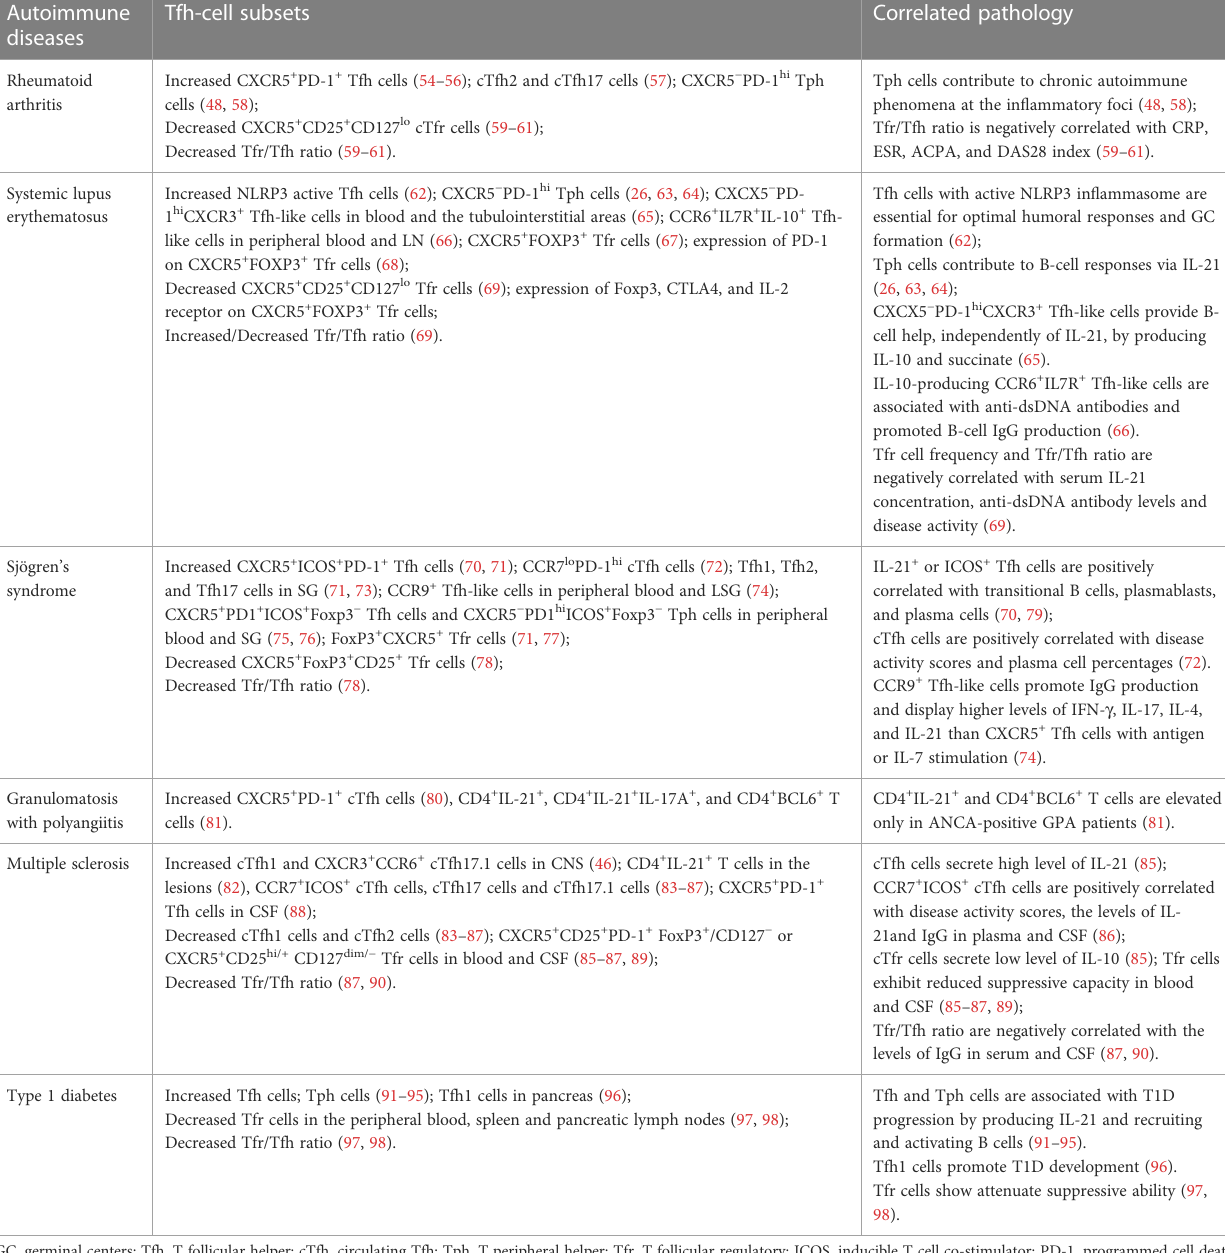
TABLE 2 Human autoimmune diseases associated with aberrant Tfh-cell function. . Autoimmune Tfh-cell subsets Correlated diseases